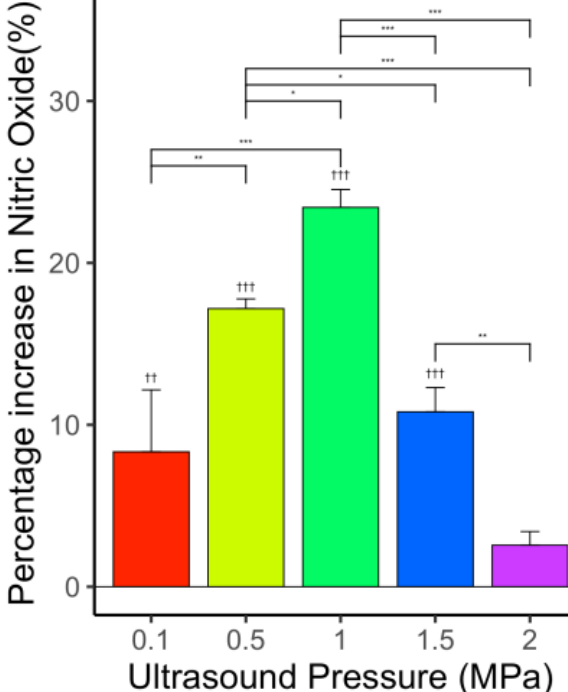
Figure 3. Effect of US on NO levels for various levels of ultrasound peak negative pressures—0.1, 0.5, 1, 1.5, and 2 MPa—showing significant increase in NO levels compared to control. N = 6 for each group. “*” indicates statistical significance between groups with p < 0.05. “**” indicates statistical significance between treatment groups with p < 0.01. “***” indicates statistical significance between groups with p < 0.001. “††” indicates statistical significance between control and treatment group p < 0.01. “†††” indicates statistical significance between control and treatment group p < 0.001.